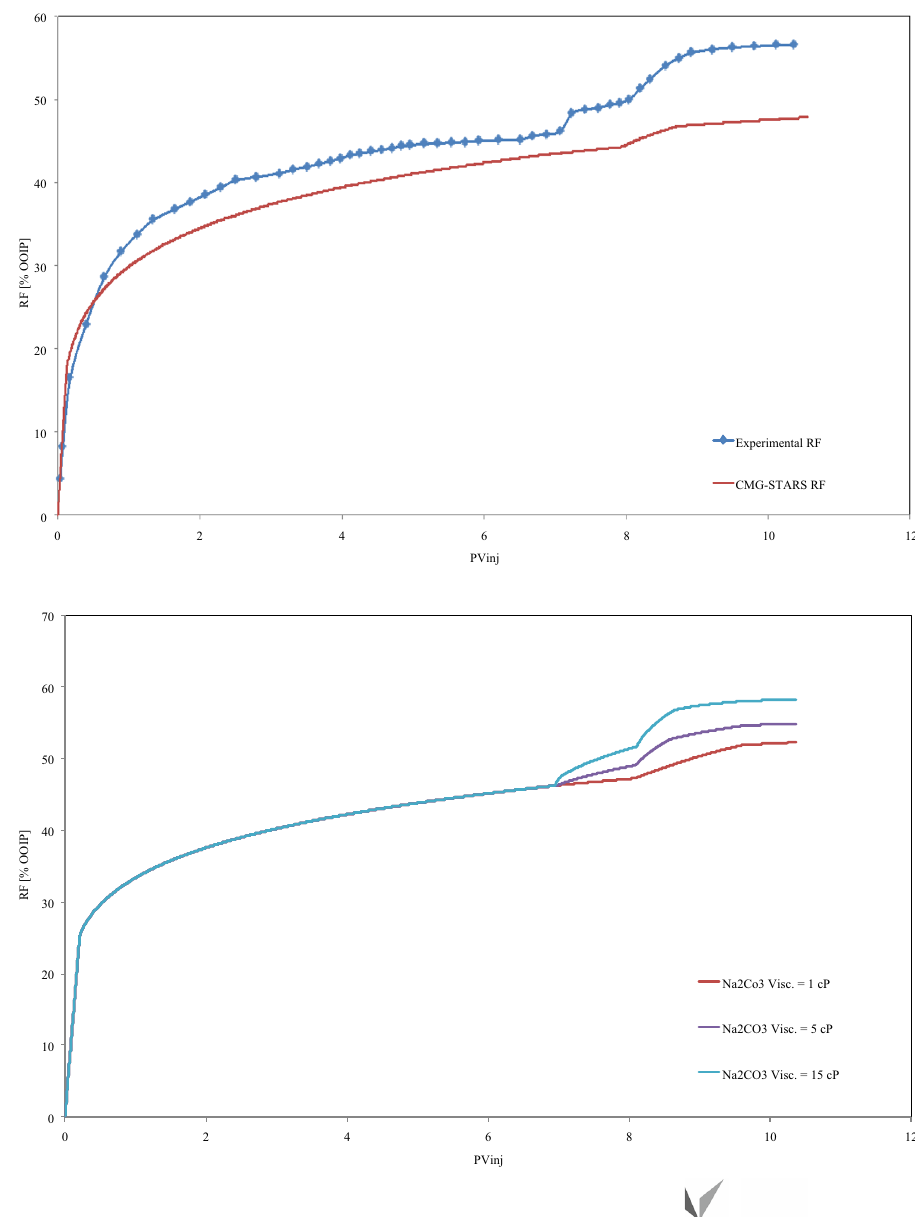
Fig. 2 Effect of applying the same experimental Akali vis- cosity and water–oil relative permeability curves on cumula- tive RF